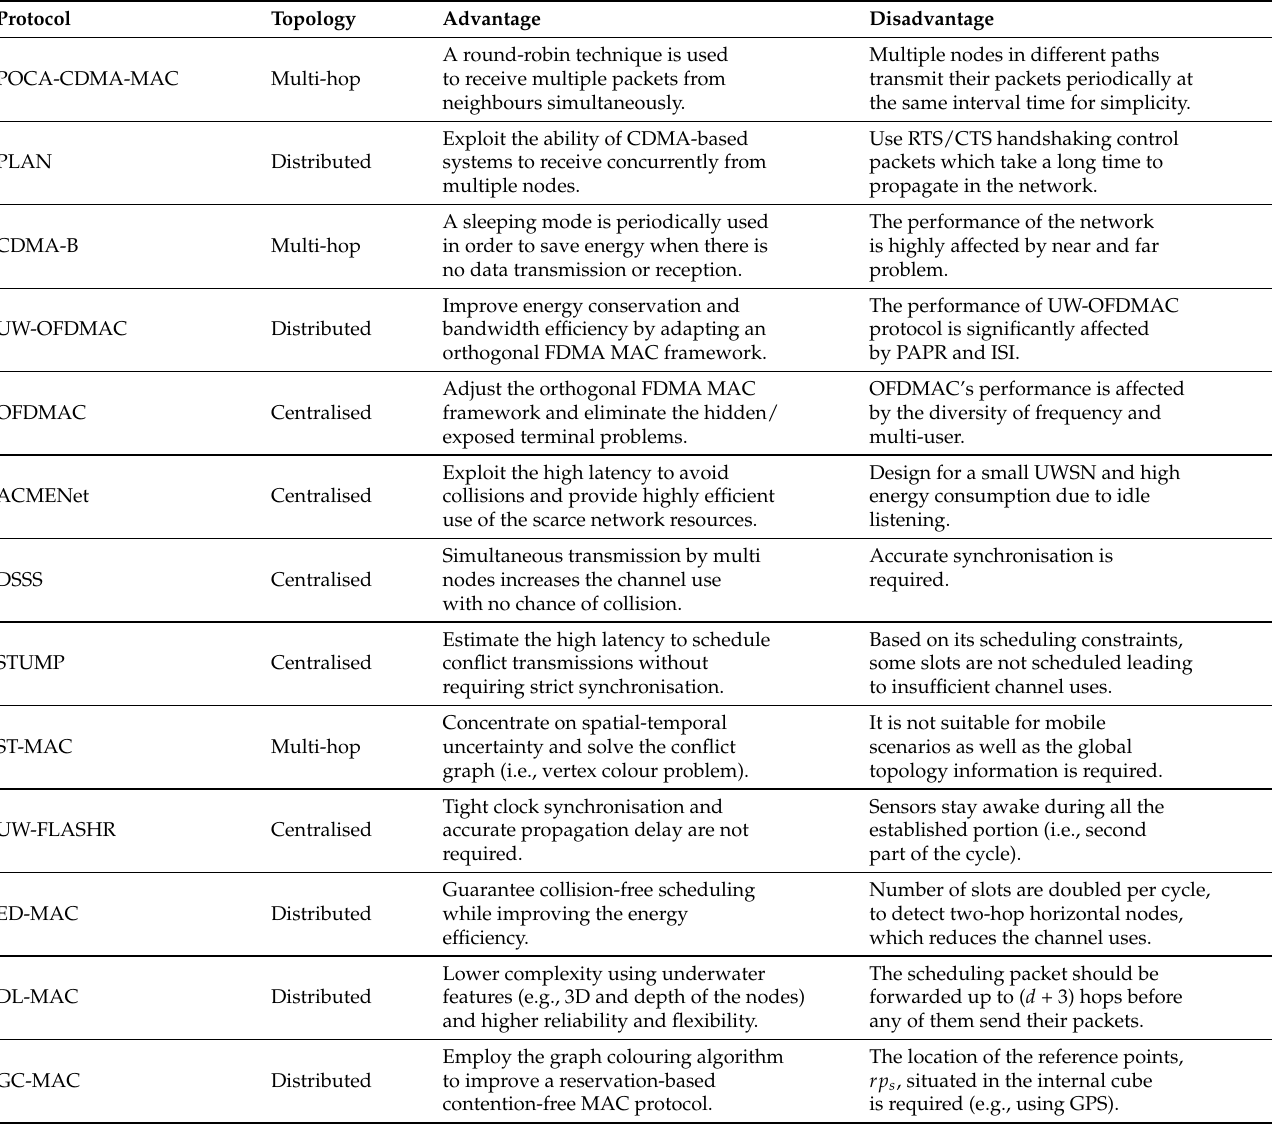
Table 3. Comparison of different underwater collision-free MAC